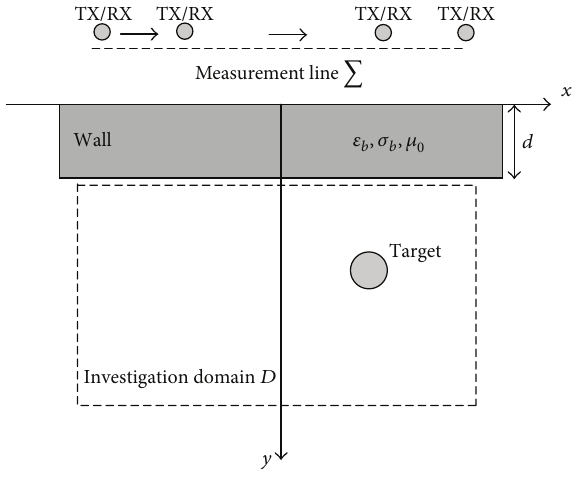
Figure 1: Geometry of the scattering